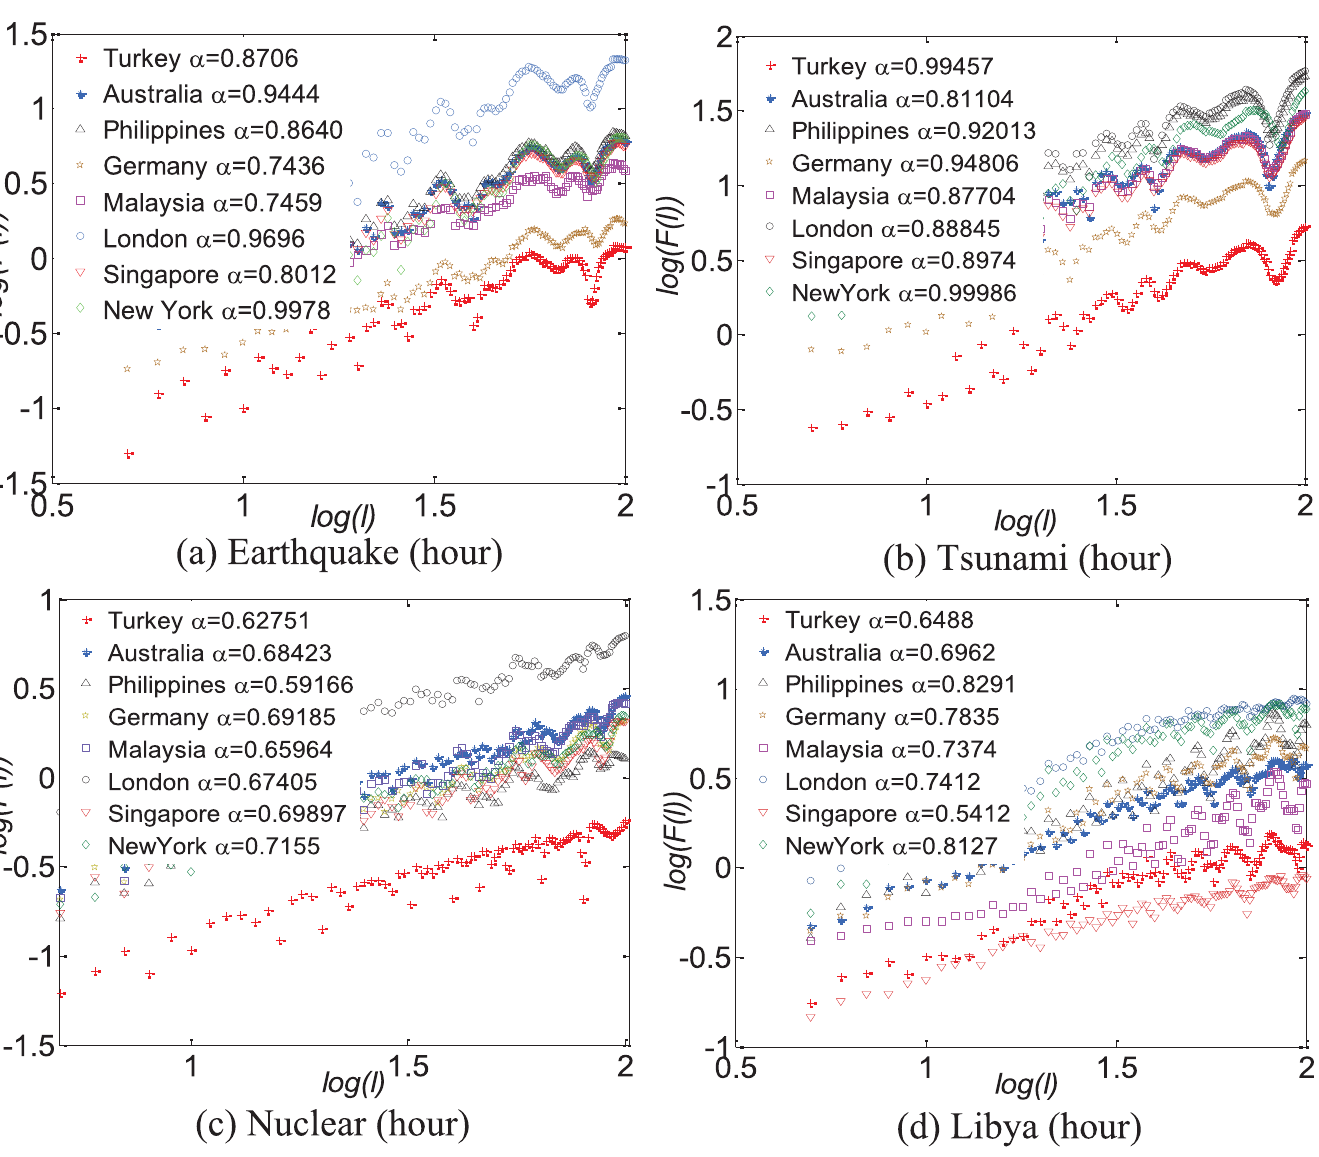
Fig 7. The results of collective time series measured by DFA in a log-log plot. The symbols represent the different regional responses to the same event. Similar scaling behaviors indicate that human collective online behaviors as a show follow a long-correlated self-similar process. Especially, such a long-range correlation is changed with time granularity. For example, the time series present long-range correlation by the hour regardless of regional profiles and the types of events. Yet the time series measured by the day, as shown in Fig K in S1 Appendix, may not be correlated based on the type of